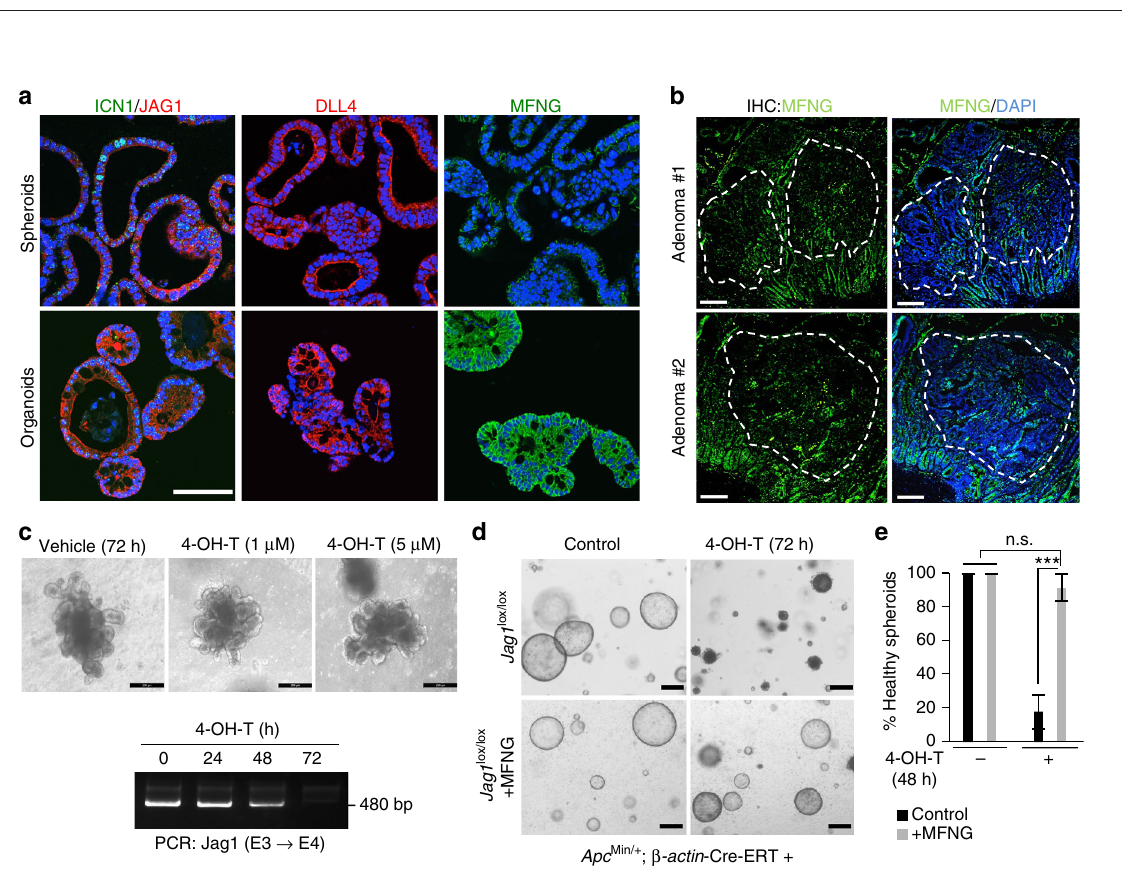
Fig. 4 Reduced levels of MFNG in intestinal adenomas impose Notch-ligand speci fi city. a IF analysis of the indicated proteins in organoid and spheroid cultures embedded in paraf fi n. b IF analysis of MFNG in paraf fi n sections of two different Apc Min/ + intestinal adenomas. Representative images are shown. c Representative images of non-transformed Jag1 lox/lox ; β - actin -Cre-ERT organoids left untreated or treated for 3 days with the indicated doses of 4-OH-tamoxifen. RT-PCR of organoids treated as indicated showing the functional wild-type band, which is deleted upon treatment. d , e Jag1 lox/lox ; β - actin -Cre-ERT adenoma cells were infected with a retroviral vector codifying for MFNG, then grown in matrigel to generate tumor spheroids, and treated with 4-OH-tamoxifen for 48 – 72 h. Representative images ( d ) and quanti fi cation of six individual wells counted per condition ( e ). Bars represent mean values ± standard error of the mean (s.e.m) from two independent experiments performed; p values were derived from an unpaired t -test, two-tailed. Scale bars represent 50 μ m in ( a ), 100 μ m in ( b ), 75 μ m in ( c ), and 200 μ m in ( d )